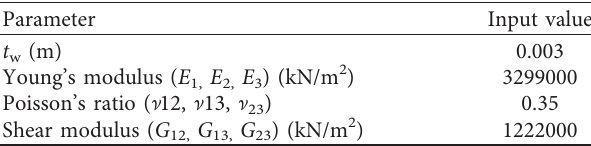
Table 5: Maximum δ max obtained from model experiments.